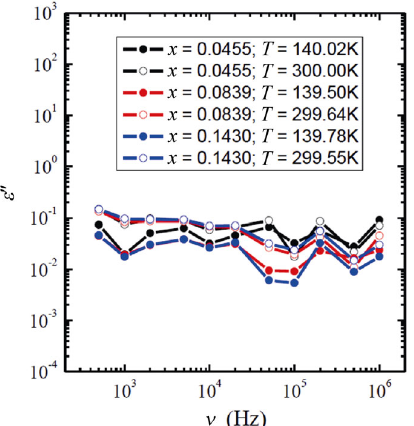
Fig. 12 Dependence of ε  ( v ) at two temperatures, 140 K and 300 K (  1 K) and for different x parameter.